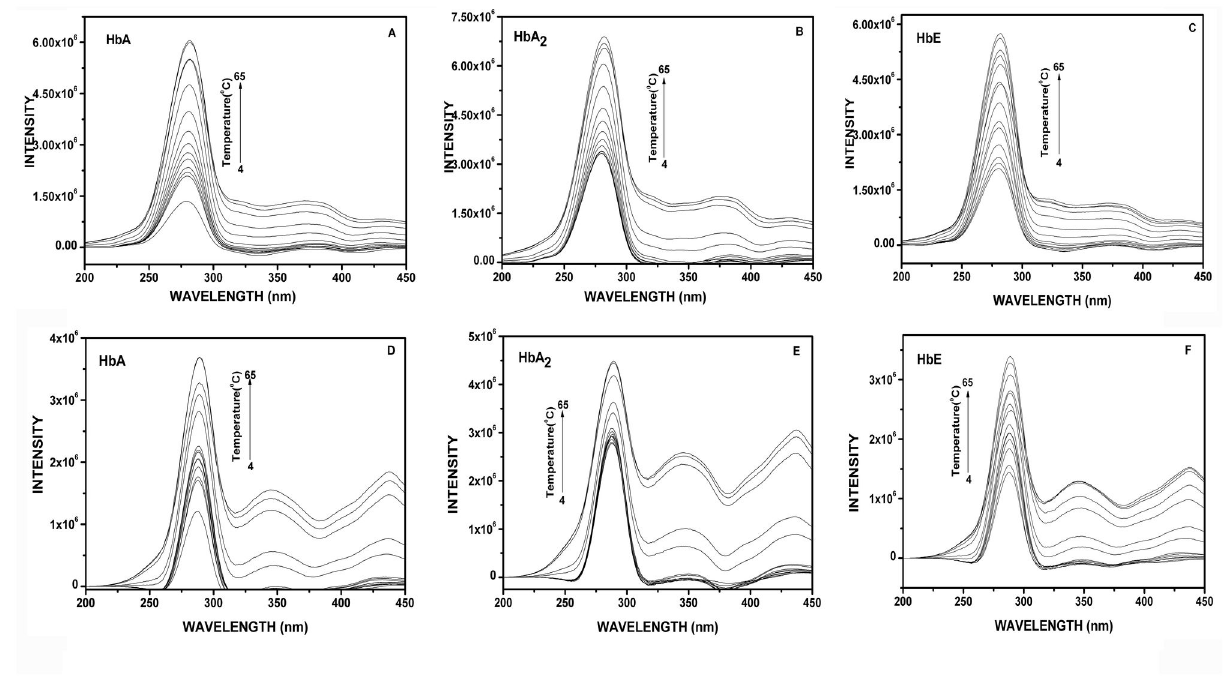
Figure 1. Synchronous fluorescence spectra for the hemoglobin variants (1.0 µM) HbA, HbA temperature from 4°C-65°C. ( A - C ) Represent the spectra for tryptophan (∆λ=80 nm) with main peak at around 280nm and auxiliary peak at 374nm and ( D - F ) represent those for the tyrosines (∆λ=20 nnm) with main peak at around 288nm and two auxiliary peaks at 348nm and 435nm. All spectra were taken at pH 7.0. The increasing intensities denote the solvent exposure of tyrosine and tryptophan residues. Auxilliary peaks in tryptophan indicate generation of other fluorophores or tyrosine derivatives.